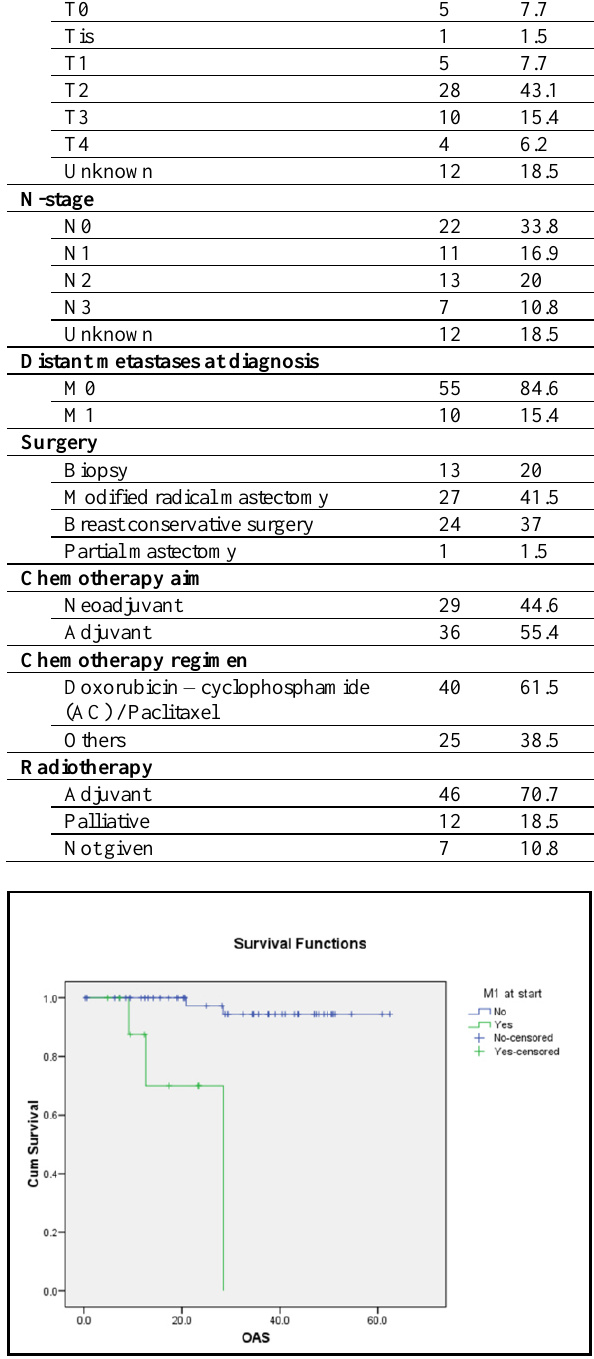
Figure 1: Kaplan-Meier curves of estimated overall survival according to metastatic status at